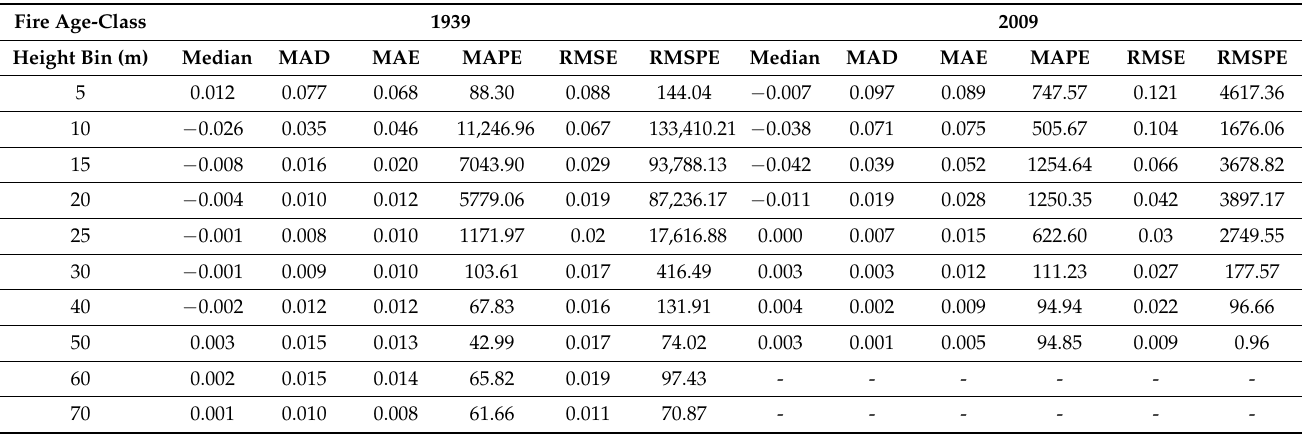
Table 9. Accuracy of GEDI PAVD of individual footprints for the two fire age-classes at different height intervals. Statistics for differences in values (ALS PAVD , GEDI PAVD